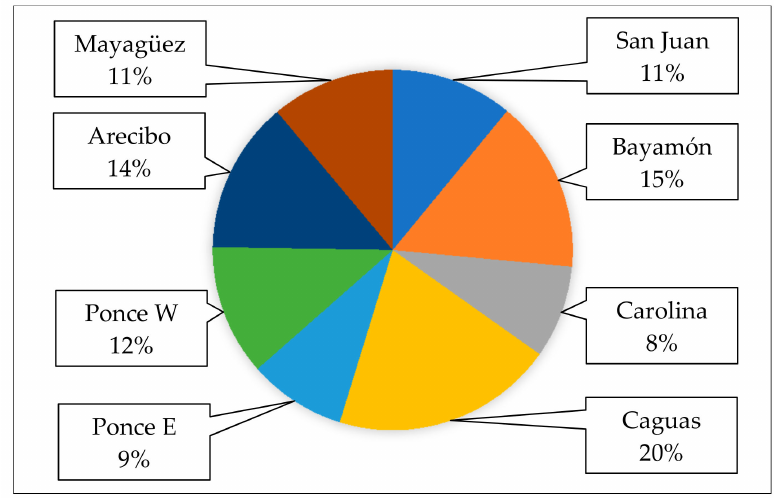
Figure 13. Resultant distribution of the potential electricity production by PV systems installed on residential rooftop surface by region in Puerto Rico in 2017.